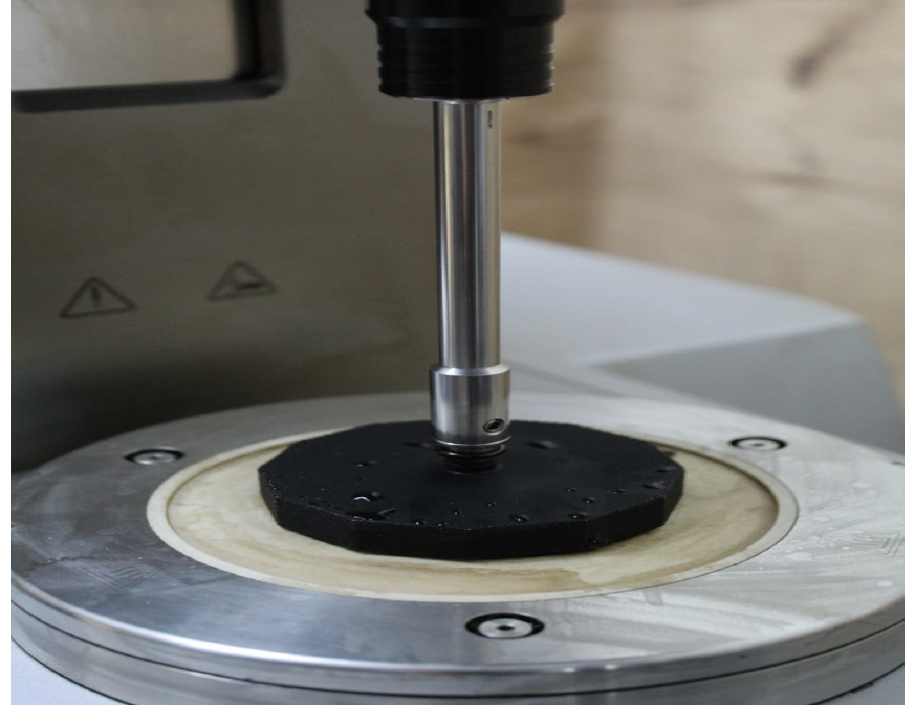
Figure 3. Specimen under experiment.